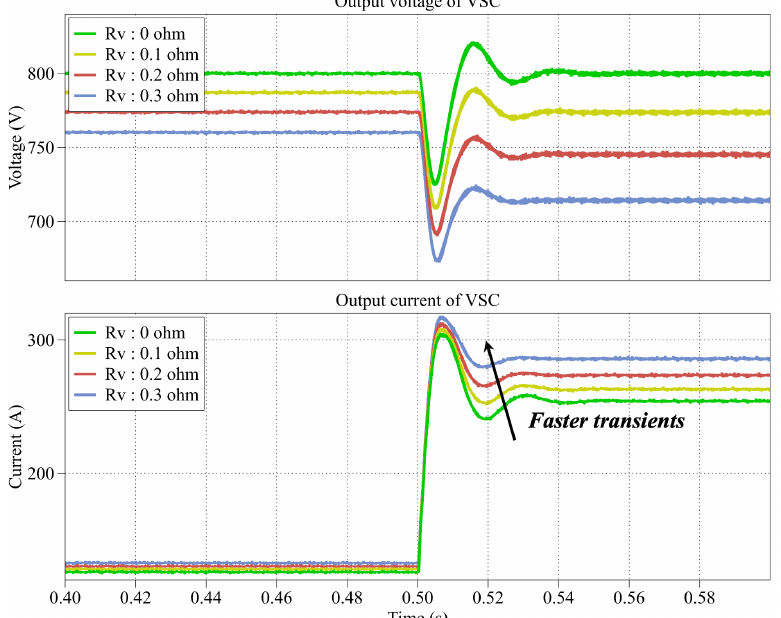
Figure 9. The transients as load steps from 50 kW to 100 kW with different virtual resistance.